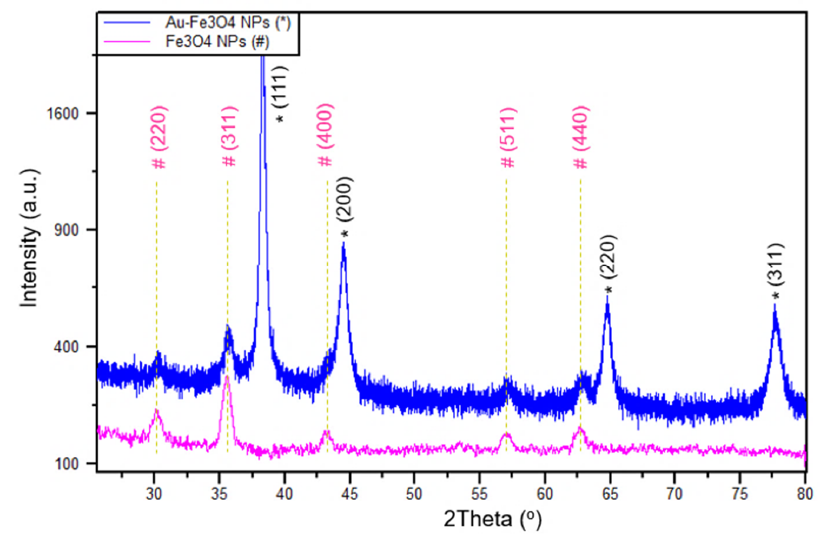
Figure 3. XRD patterns of Fe 3 O 4 NPs and Fe 3 O 4 -Au.